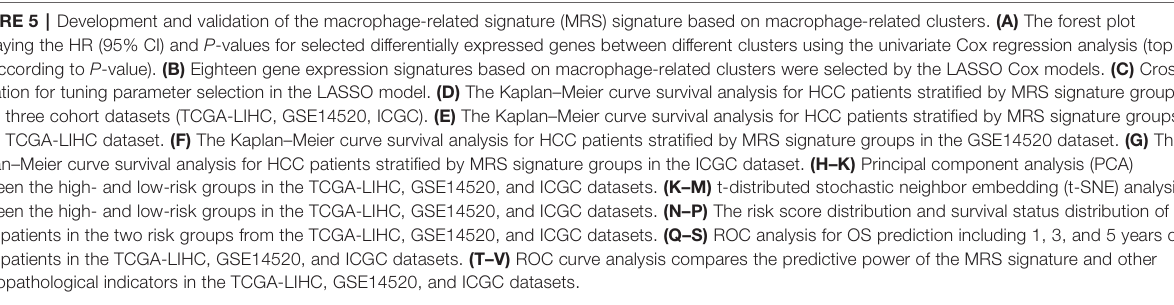
FIGURE 5 | Development and validation of the macrophage-related signature (MRS) signature based on macrophage-related clusters. (A) The forest plot displaying the HR (95% CI) and P -values for selected differentially expressed genes between different clusters using the univariate Cox regression analysis (top 30, according to P -value). (B) Eighteen gene expression signatures based on macrophage-related clusters were selected by the LASSO Cox models. (C) Cross- validation for tuning parameter selection in the LASSO model. (D) The Kaplan – Meier curve survival analysis for HCC patients strati fi ed by MRS signature groups in the three cohort datasets (TCGA-LIHC, GSE14520, ICGC). (E) The Kaplan – Meier curve survival analysis for HCC patients strati fi ed by MRS signature groups in the TCGA-LIHC dataset. (F) The Kaplan – Meier curve survival analysis for HCC patients strati fi ed by MRS signature groups in the GSE14520 dataset. (G) The Kaplan – Meier curve survival analysis for HCC patients strati fi ed by MRS signature groups in the ICGC dataset. (H – K) Principal component analysis (PCA) between the high- and low-risk groups in the TCGA-LIHC, GSE14520, and ICGC datasets. (K – M) t-distributed stochastic neighbor embedding (t-SNE) analysis between the high- and low-risk groups in the TCGA-LIHC, GSE14520, and ICGC datasets. (N – P) The risk score distribution and survival status distribution of HCC patients in the two risk groups from the TCGA-LIHC, GSE14520, and ICGC datasets. (Q – S) ROC analysis for OS prediction including 1, 3, and 5 years of HCC patients in the TCGA-LIHC, GSE14520, and ICGC datasets. (T – V) ROC curve analysis compares the predictive power of the MRS signature and other clinicopathological indicators in the TCGA-LIHC, GSE14520, and